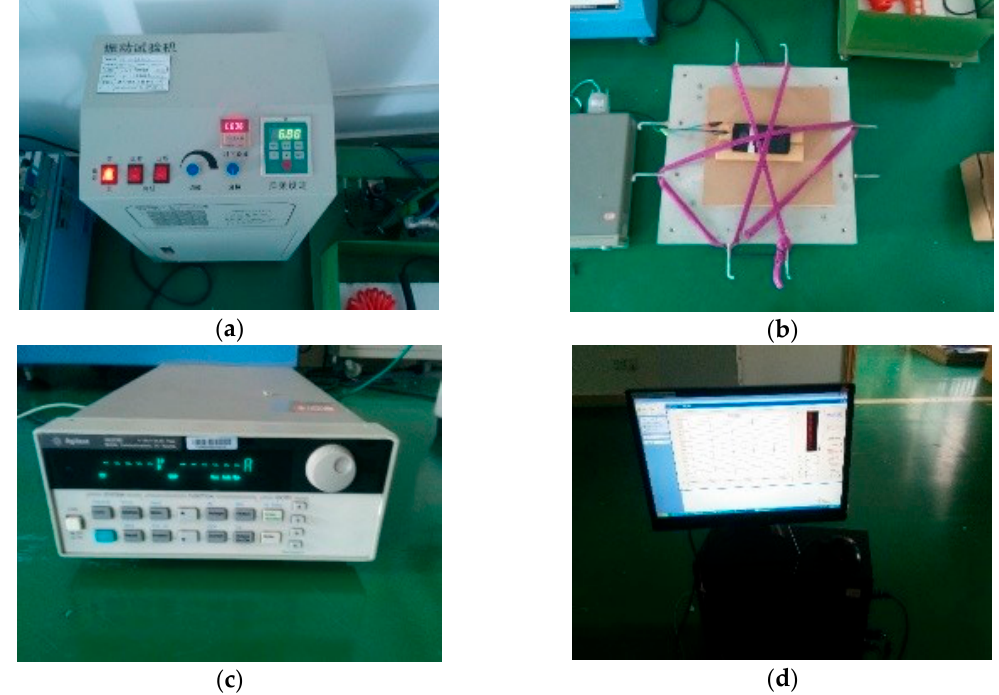
Figure 11. ( a ) Power test environments; ( b ) the phone was fixed in the shaker; ( c ) the external